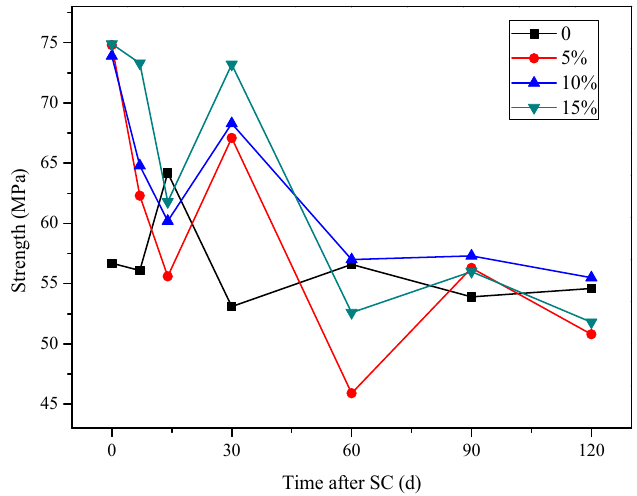
Figure 15. Strength of specimens with different silica fume content.